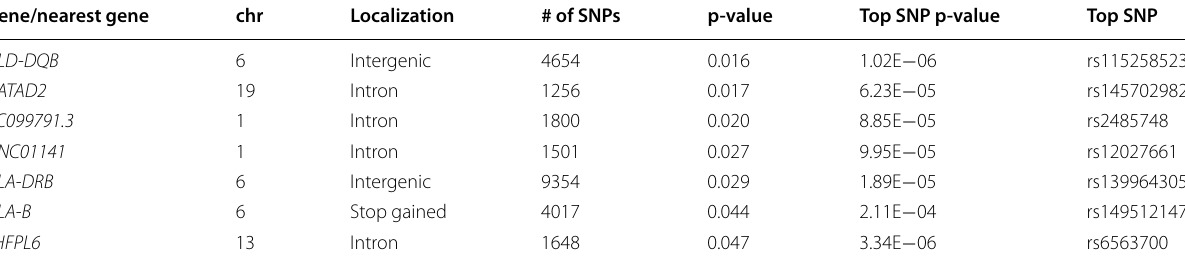
Table 5 The list of variants localized to genes associated with BMI in ARIC cohort and associated with GWG as shown by fast-BAT Gene/nearest gene